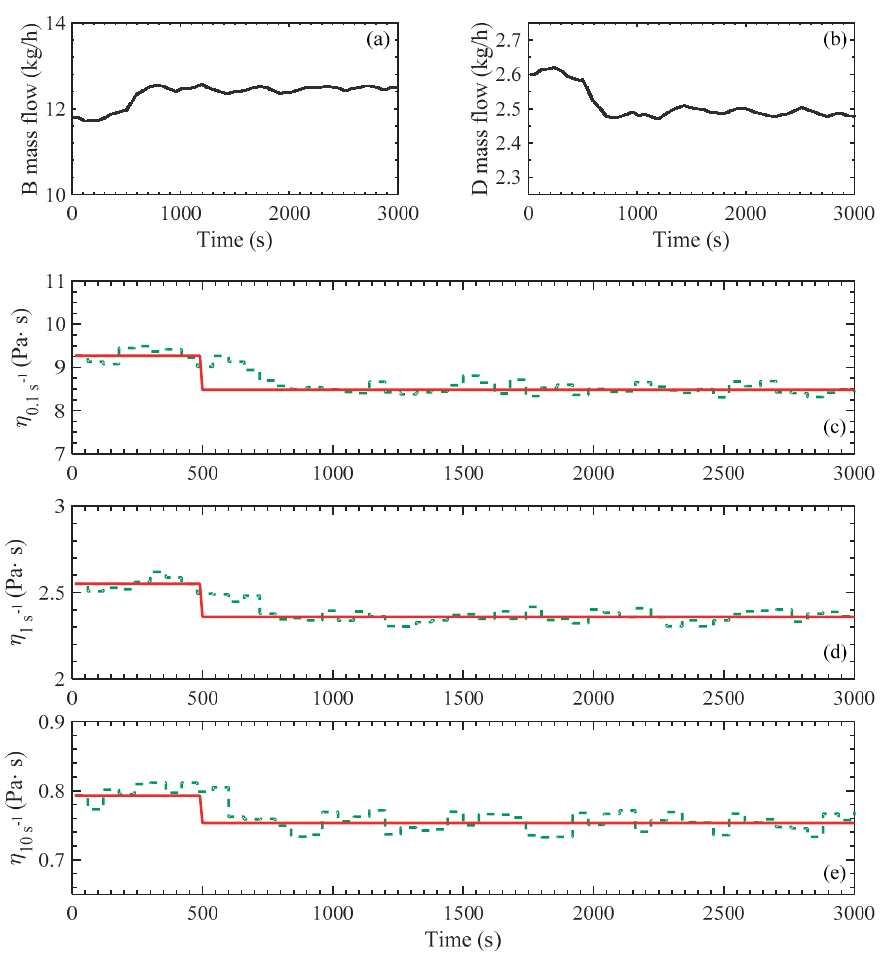
Figure 10. Performance of controller for the case with time sampling equal to 60 s: ( a ) mass flow of ingredient B; ( b ) mass flow of ingredient D; ( c ) response of the viscosity at shear rate equal to 0.1 s − 1 ; ( d ) response of the viscosity at shear rate equal to 1 s − 1 ; ( e ) response of the viscosity at shear rate equal to 10 s − 1 . For ( c – e ) the following data are reported: target curve (red solid line), measured value (green dashed line).